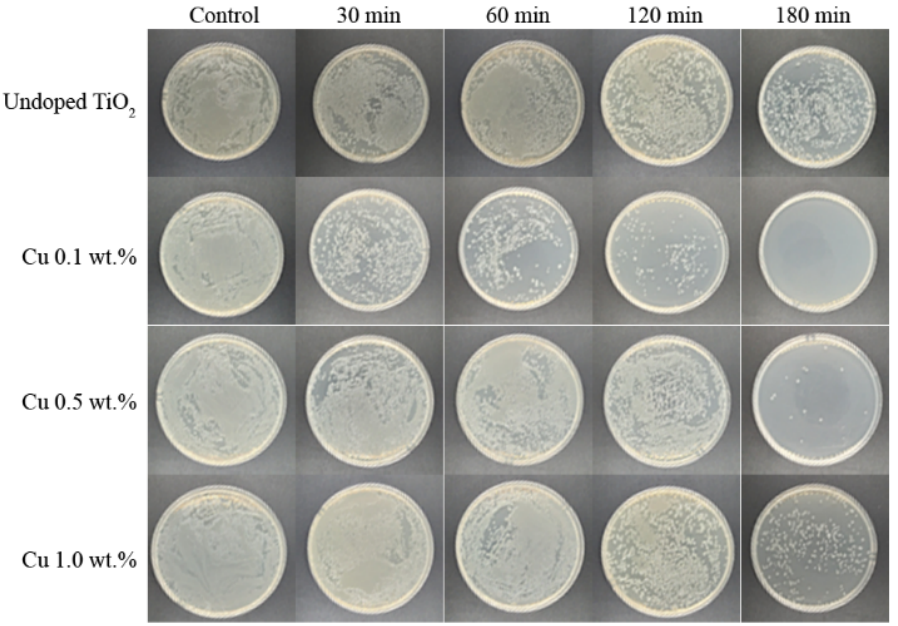
Figure 7. Photo of visible E. coli colony after UV-A radiation.